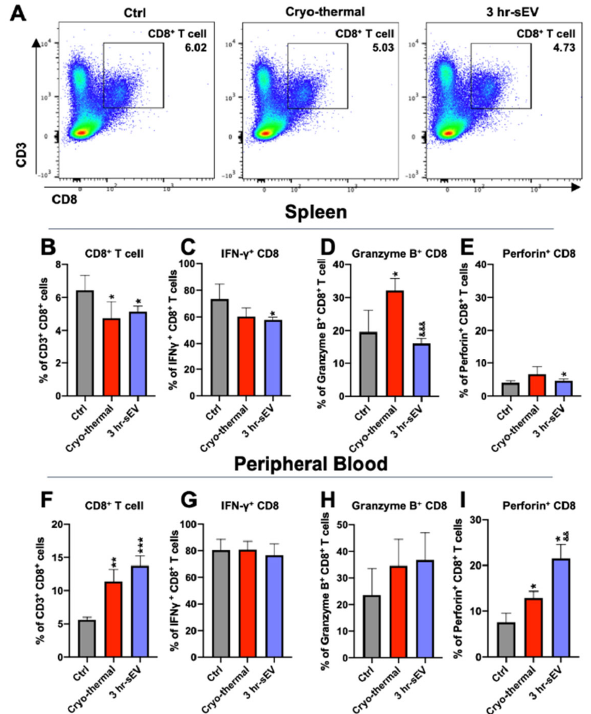
Figure 6. The released sEVs after cryo ‐ thermal therapy promoted the production of cytotoxic CD8 + T cells. ( A ) Flow cytometry gating strategy for the determination of CD3 + CD8 + T cells. ( B – E ) The proportions of CD8 + T cells ( B ), IFN ‐γ + CD8 + T cells ( C ), Granzyme B + CD8 + T cells ( D ), and Perforin + CD8 + T cells ( E ) were determined by flow cytometry. ( F – I ) The proportions of CD8 + T cells ( F ), IFN ‐ γ + CD8 + T cells ( G ), Granzyme B + CD8 + T cells ( H ), and Perforin + CD8 + T cells ( I ) were determined by using flow cytometry ( n = 4 per group). Data were shown as mean ± SD, and the Student’s t ‐ test was used for statistical analysis. n = 4, * p < 0.05, ** p < 0.01. *** p < 0.001 compared with the control group; && p < 0.01; &&& p < 0.001 compared with the cryo ‐ thermal treatment group.